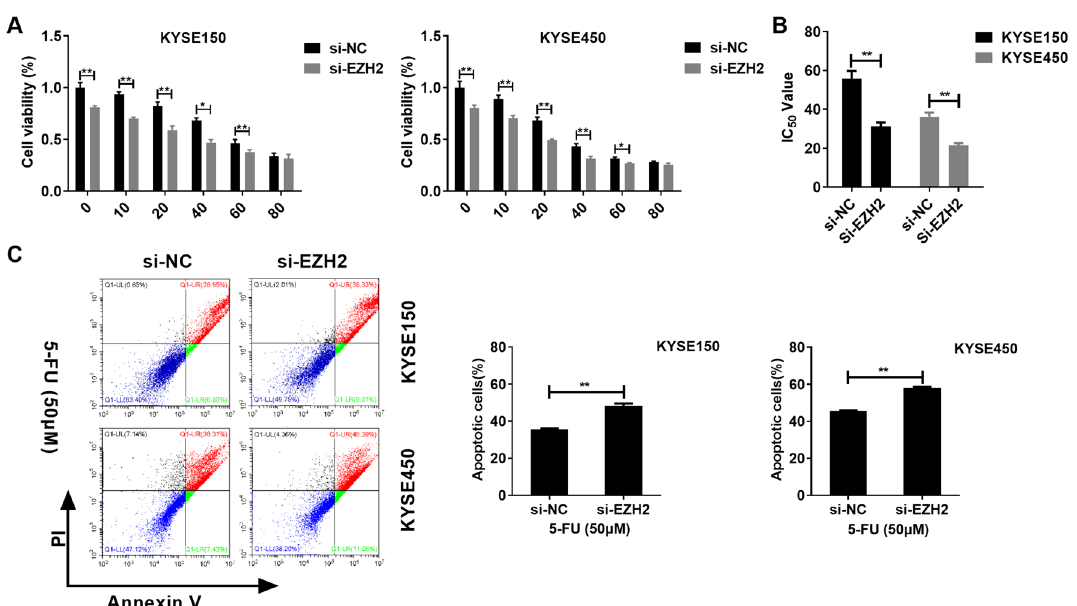
Figure 5. EZH2 inhibits EC cells sensitivity to 5-FU. ( A ) Transfection of si-EZH2 reduces EC cells viability at varying concentrations of 5-FU. ( B ) Transfection of si-EZH2 reduces the IC 50 of 5-FU to EC cells. ( C ) Transfection of si-EZH2 promotes apoptosis of EC cells. *P < 0.05; **P < 0.01 (Two-way Student’s